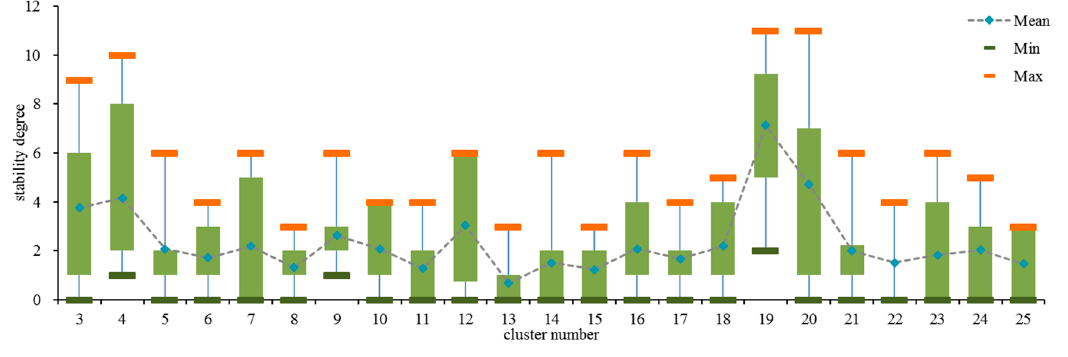
Figure 6. Stability degree boxplot for cluster number analysis.